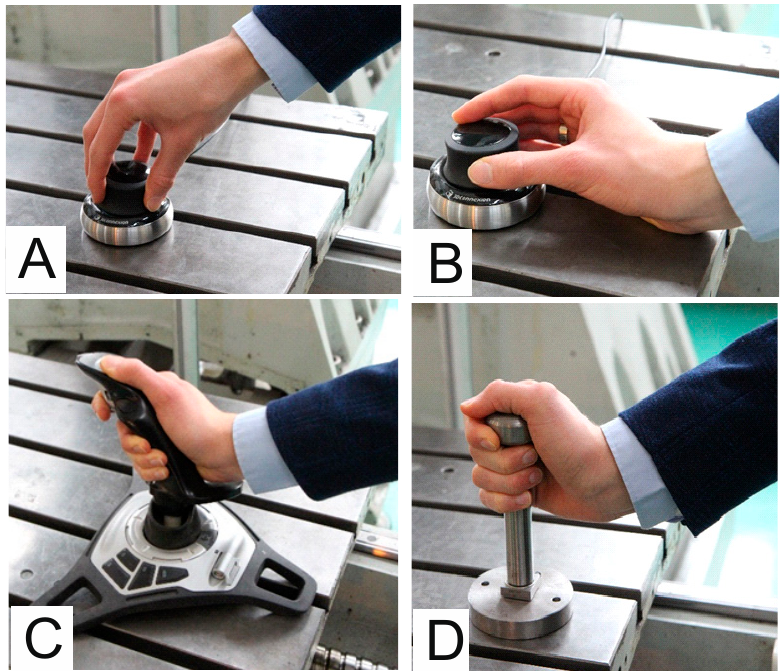
Figure 3. ( A ) 3D SpaceNavigator by 3Dconnexion—Control without wrist rest; ( B ) 3D SpaceNavigator by 3Dconnexion—control with wrist rest; ( C ) Logitech Freedom™ 2.4 Cordless steering through pivoting; ( D ) piezo sensor handle design.